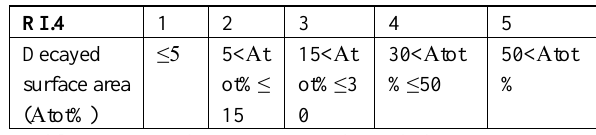
Table 5. Semi quantitative determination of the anions ‘soluble fraction  Decay patterns mapping RI.4 : concerns the surface decay mapping using various mapping techniques such as photography, photogrammetry etc., resulting to the in the quantification of micro cracks, crusts, exfoliations, detachments, alveolar decay, etc. This is achieved by estimating the percentage of the surface area occupied by each of the above decay types in relation to the appropriate weighting factor.